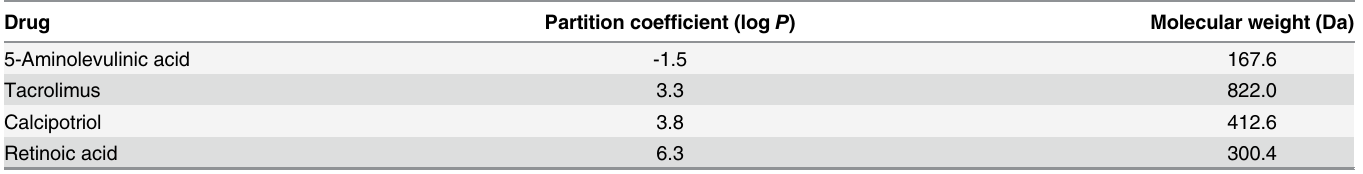
Table 2. Physicochemical properties of the drug molecules tested in this